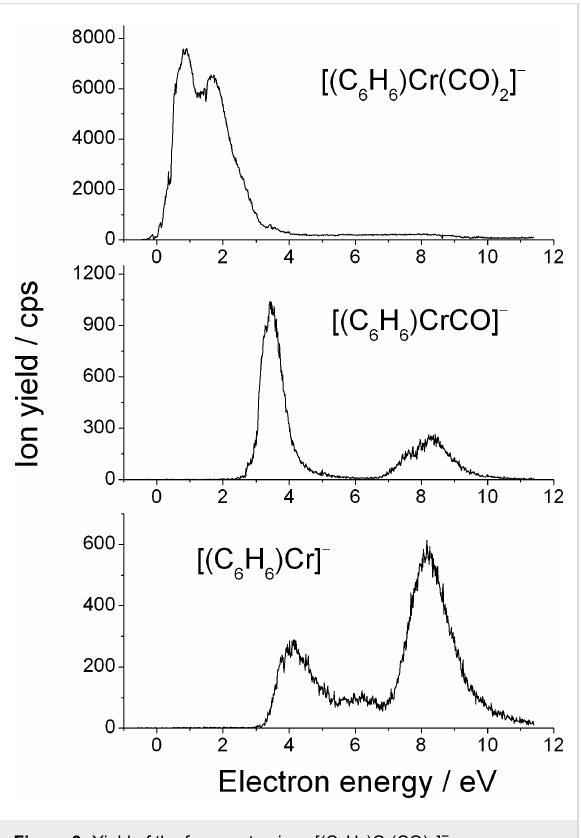
Figure 3: Yield of the fragment anions [(C 6 H 6 )Cr(CO) 2 ] − , [(C 6 H 6 )Cr(CO)] − , and [(C 6 H 6 )Cr] − obtained from DEA to benzene- chromium(0) tricarbonyl which are generated by the loss of one, two, and three carbonyl groups, respectively.